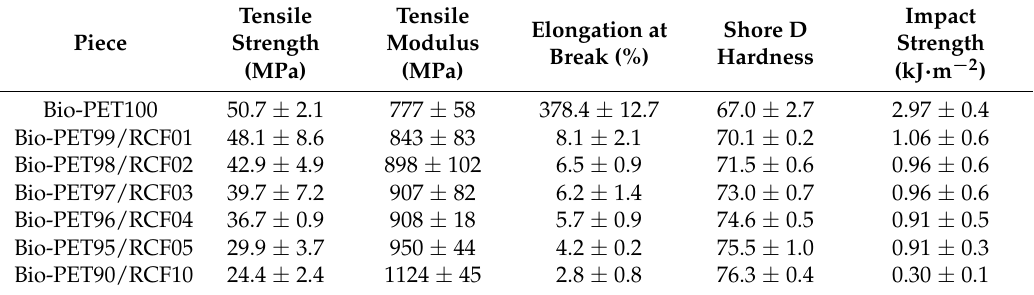
Summary of the mechanical properties of the bio-based polyethylene terephthalate (bio-PET)/recycled cotton fiber (RCF) composite